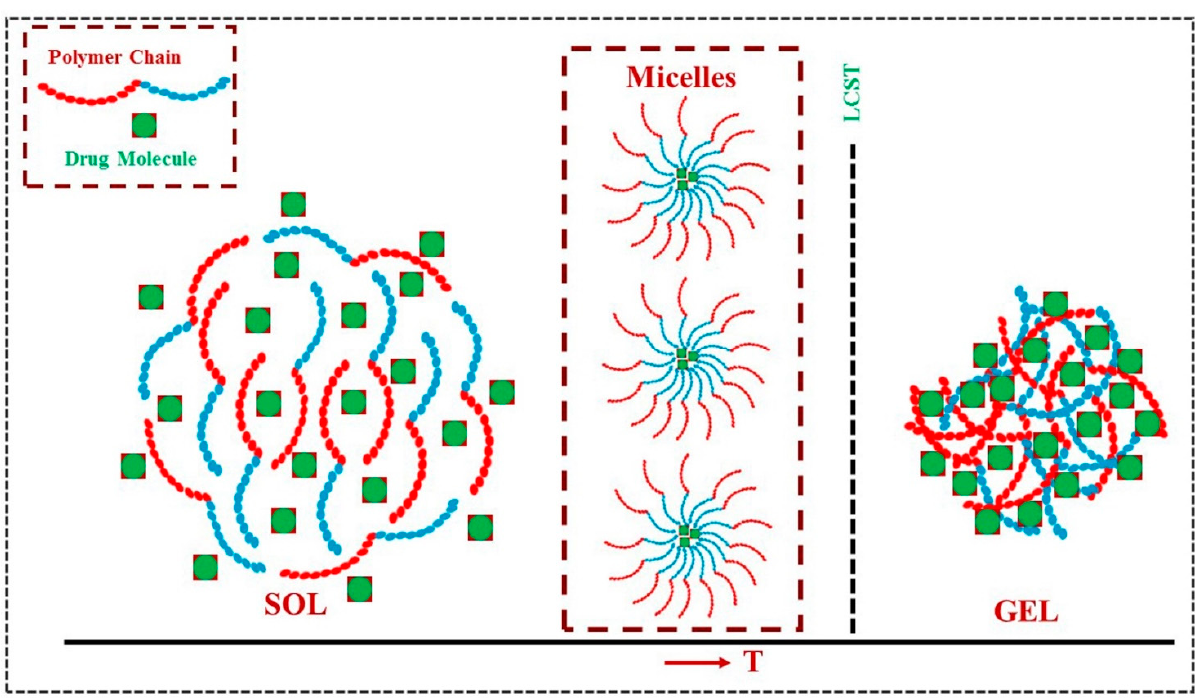
Figure 1. The sol–gel transition of LCST-type thermo-responsive polymer-based drug delivery system (Schematic presen- tation). Formulation over LCST changes to hydrogel from the solution state. LCST-type thermo-responsive polymer in solution forms micelles at low concentration and that further aggregates at high polymer concentration to form gel at a temperature ( ≥ LCST).